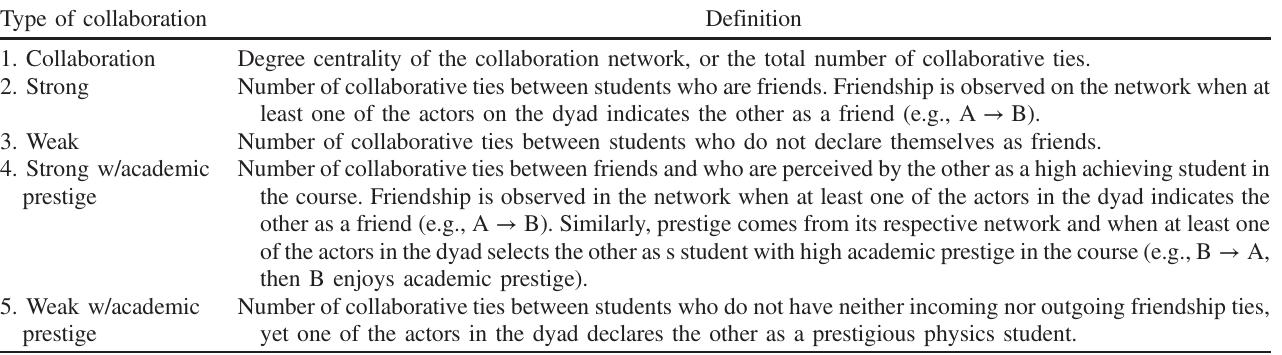
TABLE III. Types of collaborative relationships and definition.